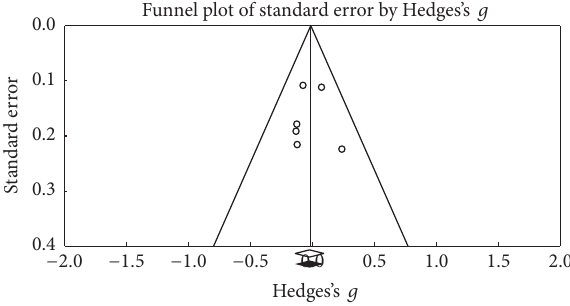
Hedges’s g Funnel plot of standard error by